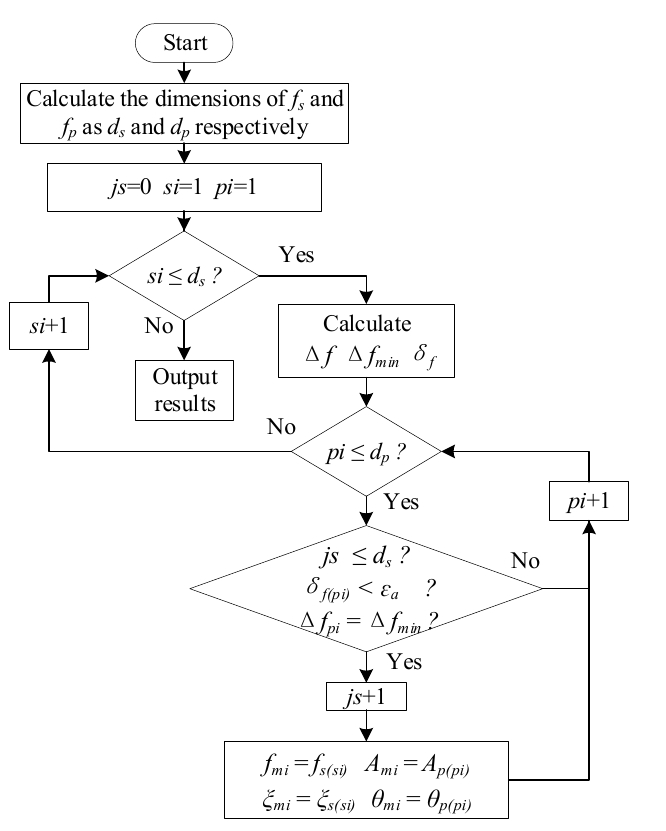
Figure 2. Flowchart of parameter matching approach in the proposed SMPI method.